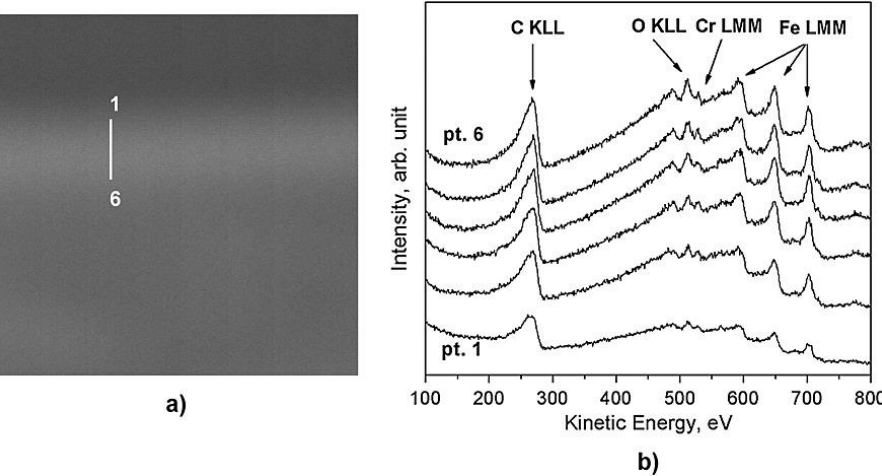
Figure 24. SEM image (24 × 24 µm 2 ) of the sample treated by plasma at CH 4 2% in H 2 ( a ), and Auger spectra ( b ) recorded in points 1–6 are marked in the SEM image [37].